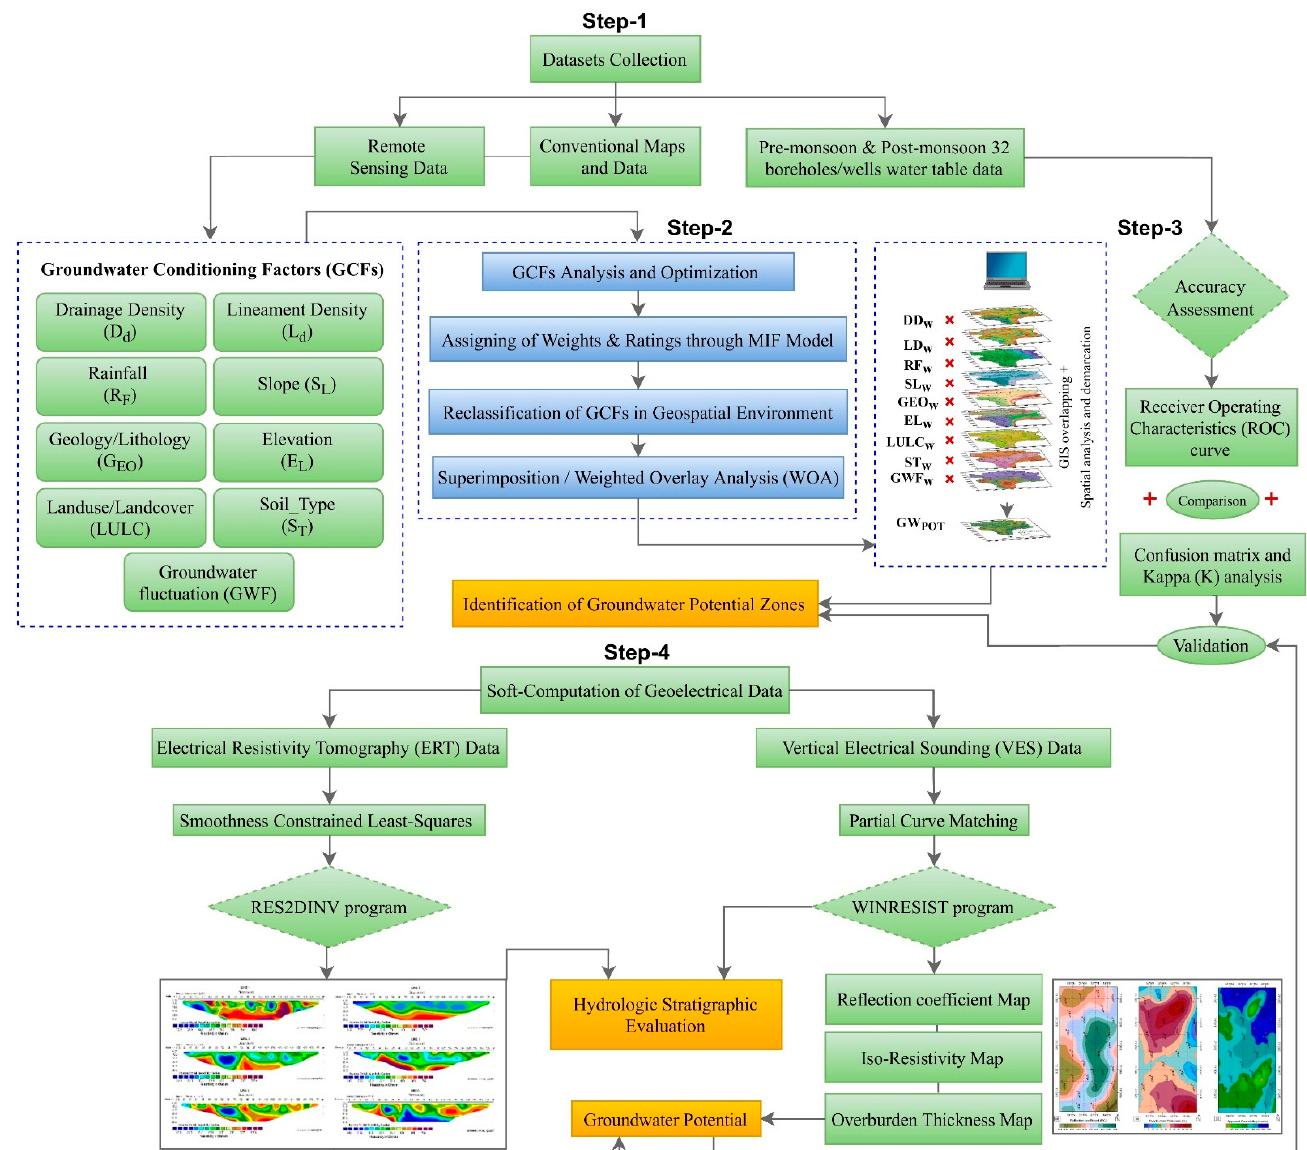
Figure 3. Framework to delineate groundwater potential and to identify hydrogeological characteristics.